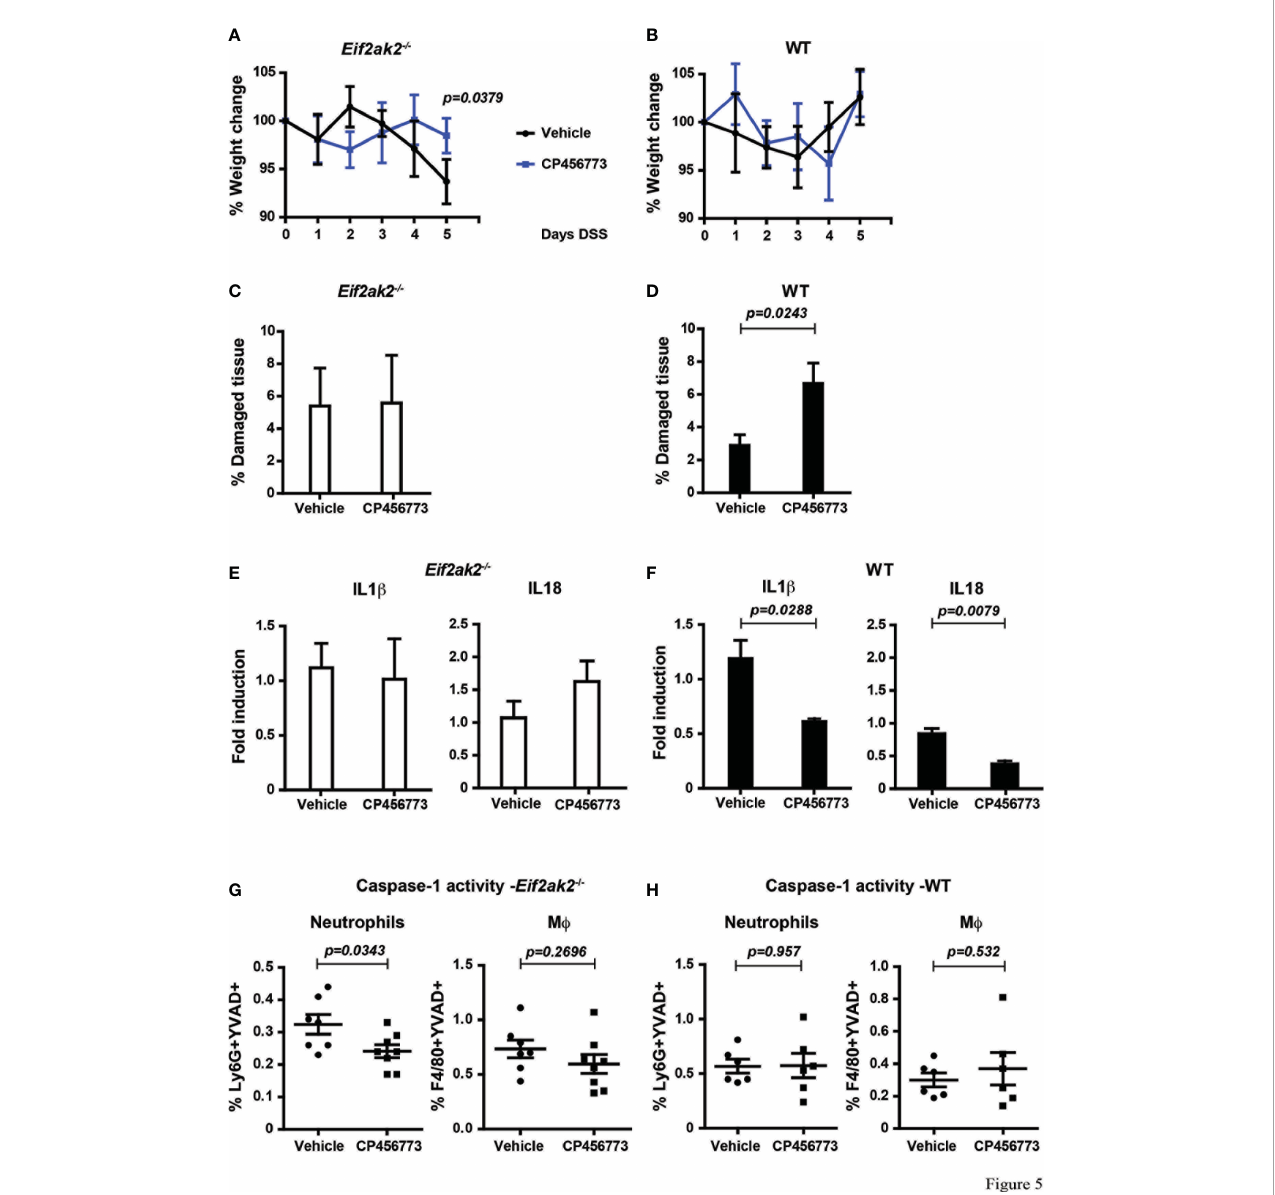
FIGURE 5 Inhibiting NLRP3 restores control in the absence of PKR expression. (A, B) Body weights of mice treated with DSS and injected with either the NLRP3 inhibitor CP456773 or the control vehicle solute, expressed as the percentage change from the starting weight of (A) PKR-ablated ( Eif2ak2 -/- ) or (B) WT mice (n=6) and analyzed by two-way ANOVA with S ̌ idàk post-test. (C, D) Measures of the effect of CP456773 on DSS-induced tissue damage, expressed as the percentage of the entire length of the colon in either (C) PKR-ablated or (D) WT mice (n = 6) and analyzed by unpaired t-test. (E, F) Measures of the effect of CP456773 on the relative change in the levels of mature IL1 b and IL18 produced from colon explants from either (E) PKR-ablated or (F) WT mice treated with the inhibitor (WT+Vehicle and WT+CP456773 n=3; Eif2ak2 -/- +Vehicle n=4; Eif2ak2 -/- +CP456773 n=5). Cytokines were assayed by immune blot and expressed as fold induction compared to Vehicle-treated mice and analyzed by unpaired t-test. (G, H) Casp1 activity (YVAD+) in splenic neutrophils (FLICA + Ly6G + ) or macrophages (M f , FLICA + F4/80 + ) from either (G) PKR-ablated or (H) WT mice treated with the NLRP3 inhibitor (n=7